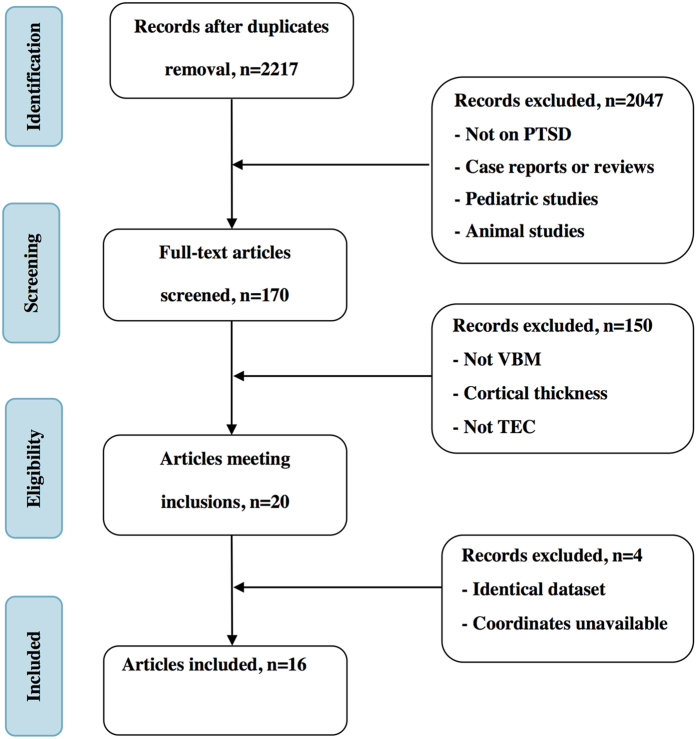
Flowchart of the literature selection in the present study.